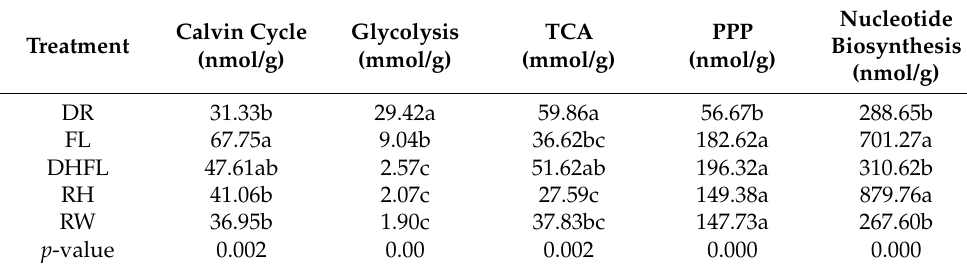
Table 1. Total metabolites involved in specific central carbon metabolic routes in Mexican mint ( Plectranthus amboinicus ) plants under varying watering